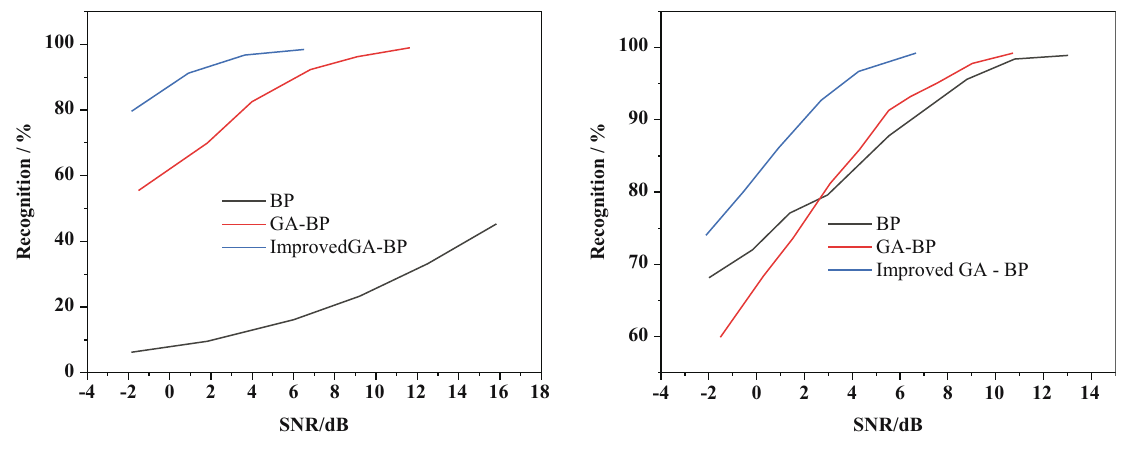
Figure 6: Failure of Type 2. Figure 7: Failure of